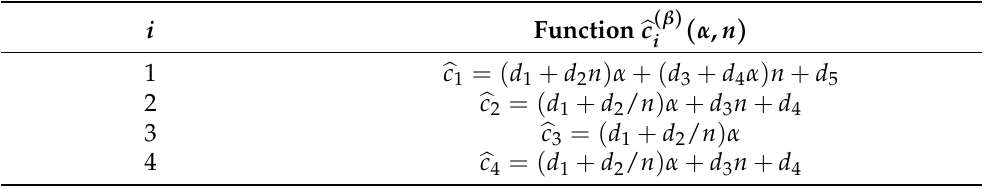
( β ) ( α , n ) fitting the coefficients (cid:98) c i